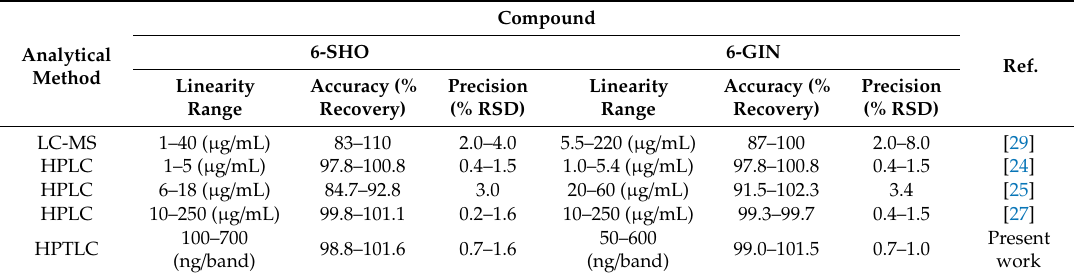
Table 5. Comparison of the current green RP-HPTLC method with reported analytical methods for the simultaneous determination of 6-SHO and 6-GIN.